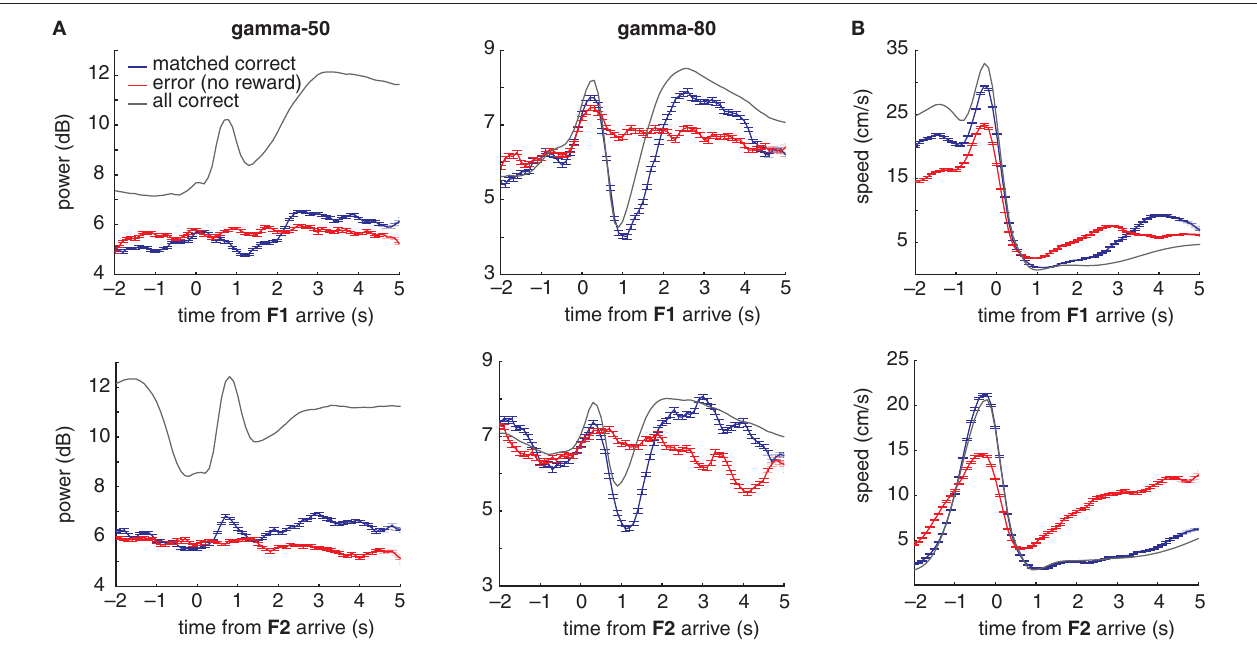
FIGURE 9 | Gamma-50 and gamma-80 power are differentially modulated around the time of reward receipt. (A) Peri-event power averages, aligned to arrival times at the fi rst reward site (F1, top) or the second reward site (F2, bottom) for gamma-50 (left column) and gamma-80 (right). As before, error laps (no reward received, red line) were matched with a set of correct laps that occurred at comparable times within sessions (blue line). The average for all correct laps is shown in grey. Food pellet reward usually arrived within 0.5 s of the rat’s arrival at reward sites. Over all correct laps, a clear response to reward